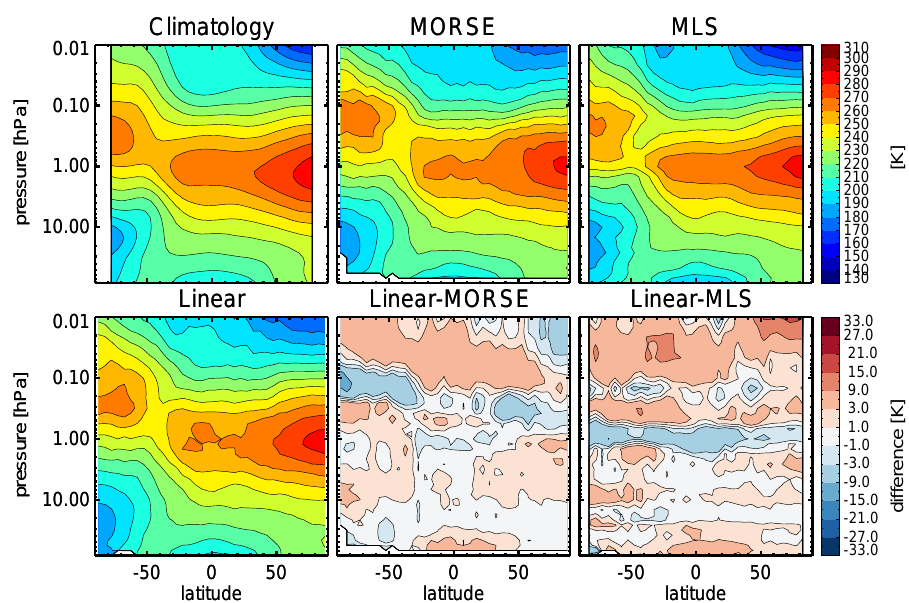
Fig. 17. Temperature zonal mean for 7 June 2007 for climatology, MORSE, MLS and the MIPAS linear retrieval. The top row displays climatology, MORSE and MLS, while the bottom row displays the MIPAS linear retrieval results as well as the absolute difference between the retrievals (linear − MORSE and linear − MLS). Note that the absolute difference contours are not equally spaced.